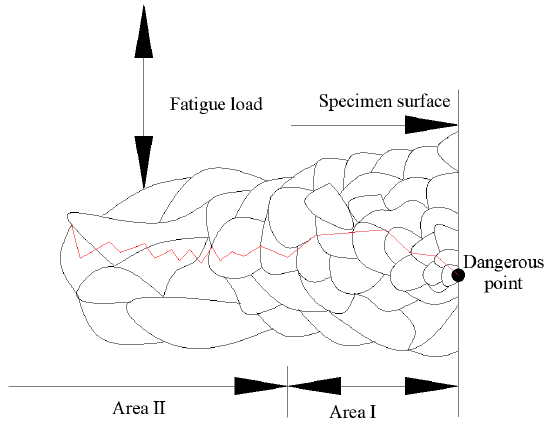
Figure 1. Crack extension process.